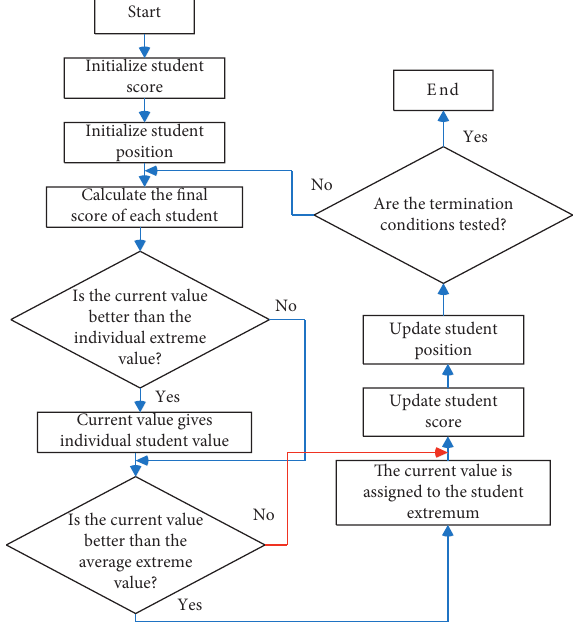
Figure 2: ELT achievement data mining